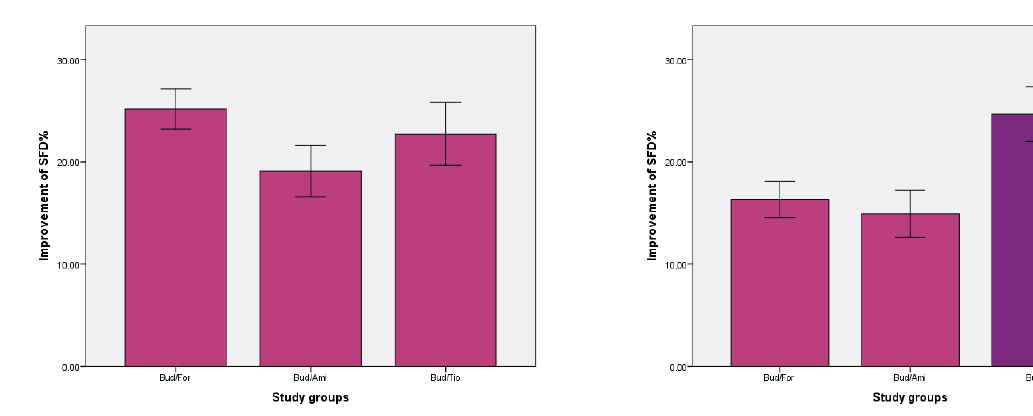
Figure 5. Comparison of groups according to extent of change in percentages of SFDs during the first four weeks of study Bud/For (First group): Budesonide/Formoterol Bud / Ami (Second group): Budesonide / Aminophylline Bud/Tio (Third group): Budesonide/Tiotropium Significant difference was noted among the groups during the 4 th – 8 th weeks of study; the third group produced significantly the best increment in the percentage of SFDs compared to the remaining groups (p=0.01 each). Although the first group developed numerically larger extent of SFDs increment, there was non- significant difference observed between first and second groups (p=0.75) as shown in figure 6.